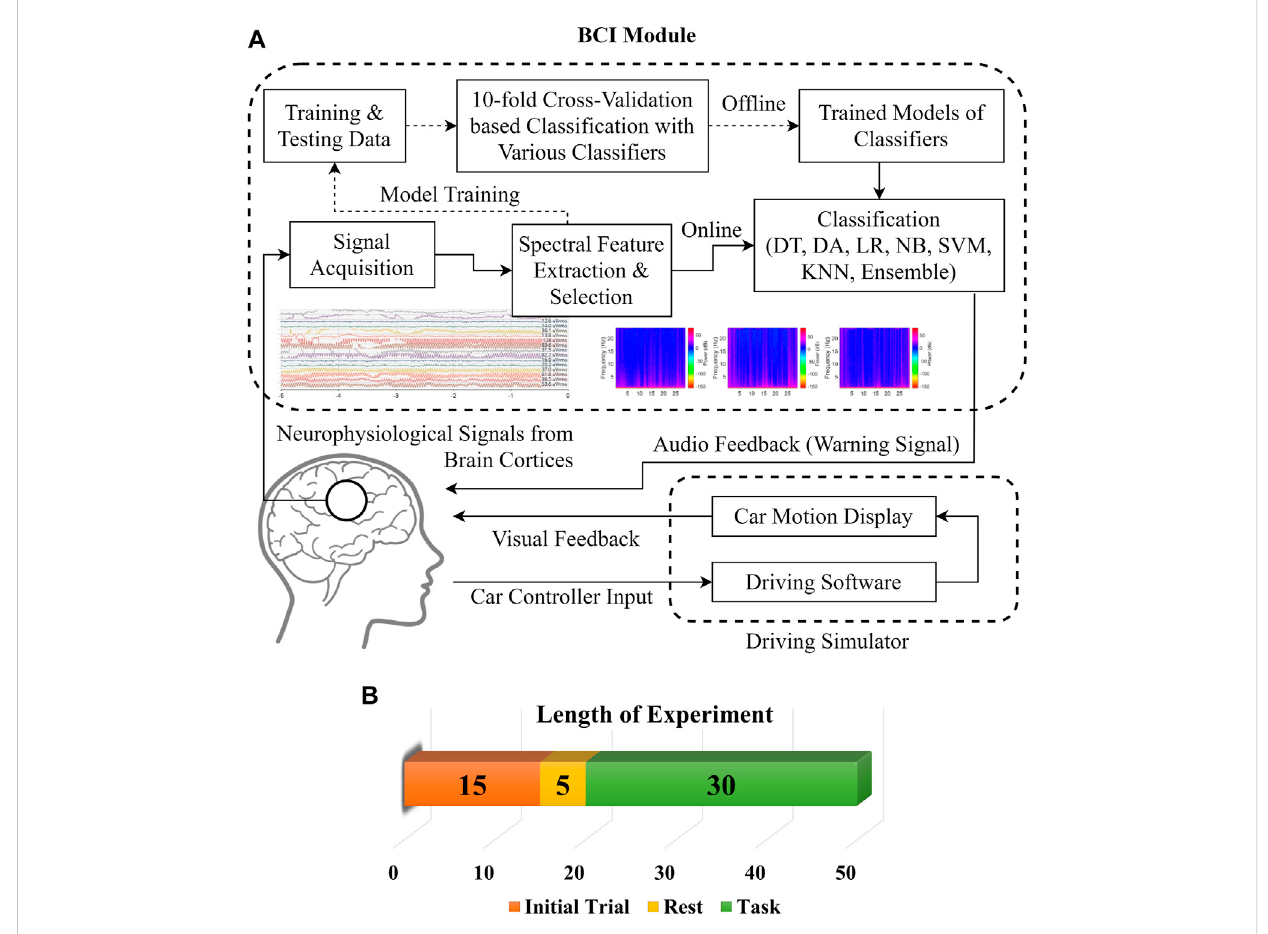
FIGURE 1 (A) Process fl ow diagram for BCI module. (B) Experiment